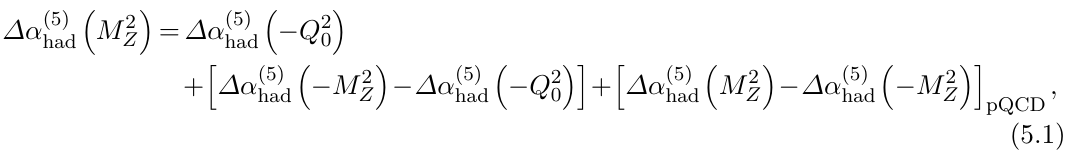
Table 7 . The contribution from [ ∆α (5) The second column is based on the pQCD 0 [Adler] approach in eq. (5.2). The third column is obtained with KNT18[data] approach in eq. (5.3). See the text for